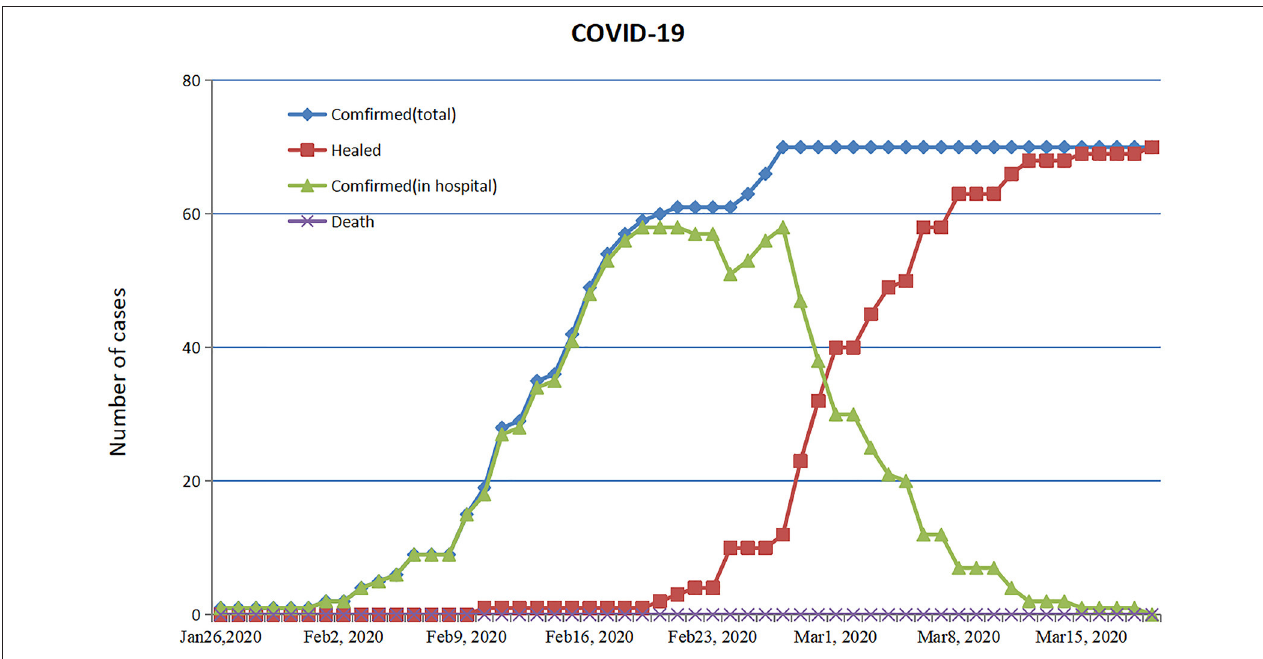
FIGURE 5 | Timeline of treatment and clinical outcomes. Trend chart of confirmed cases of COVID-19 through 19 March 2020.